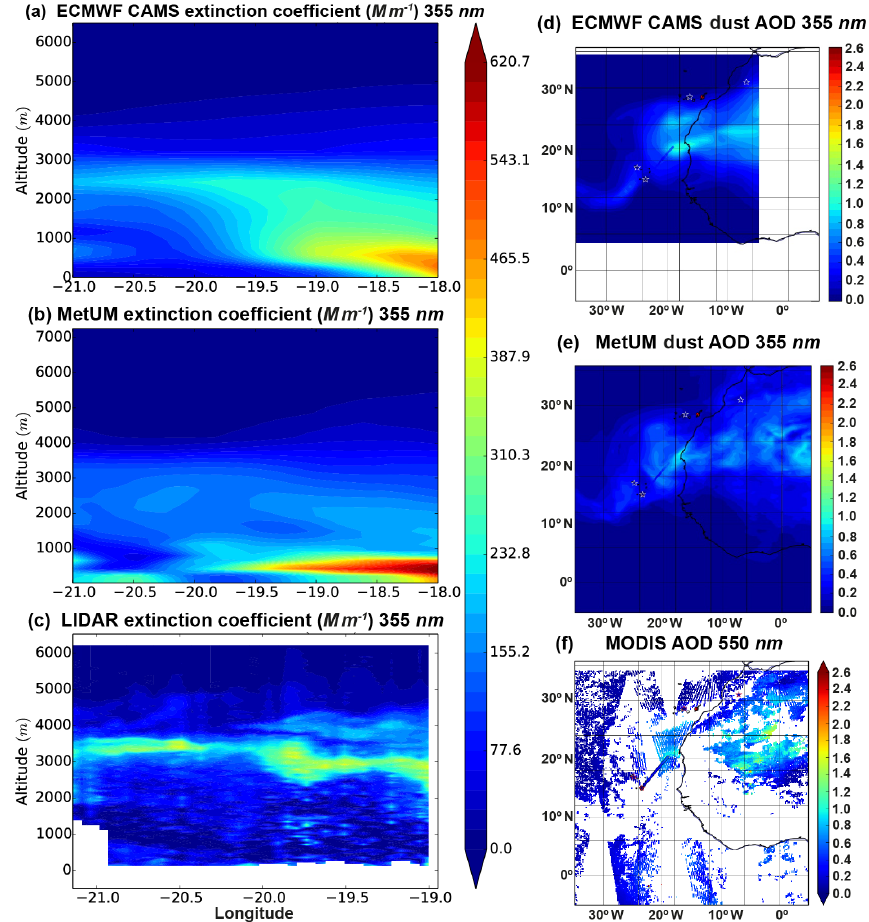
Figure 14. Case study 4, B932, 20 August, R1: (a–c) vertical cross section along the flight track showing the aerosol extinction coefficient for ECMWF–CAMS (a) , MetUM (b) , and the aircraft lidar (c) ; the colour scale is the same for all four plots. (d) ECMWF AOD map, (e) MetUM AOD map, and (f) AOD map from combined observations from MODIS, AERONET (stars), and aircraft lidar